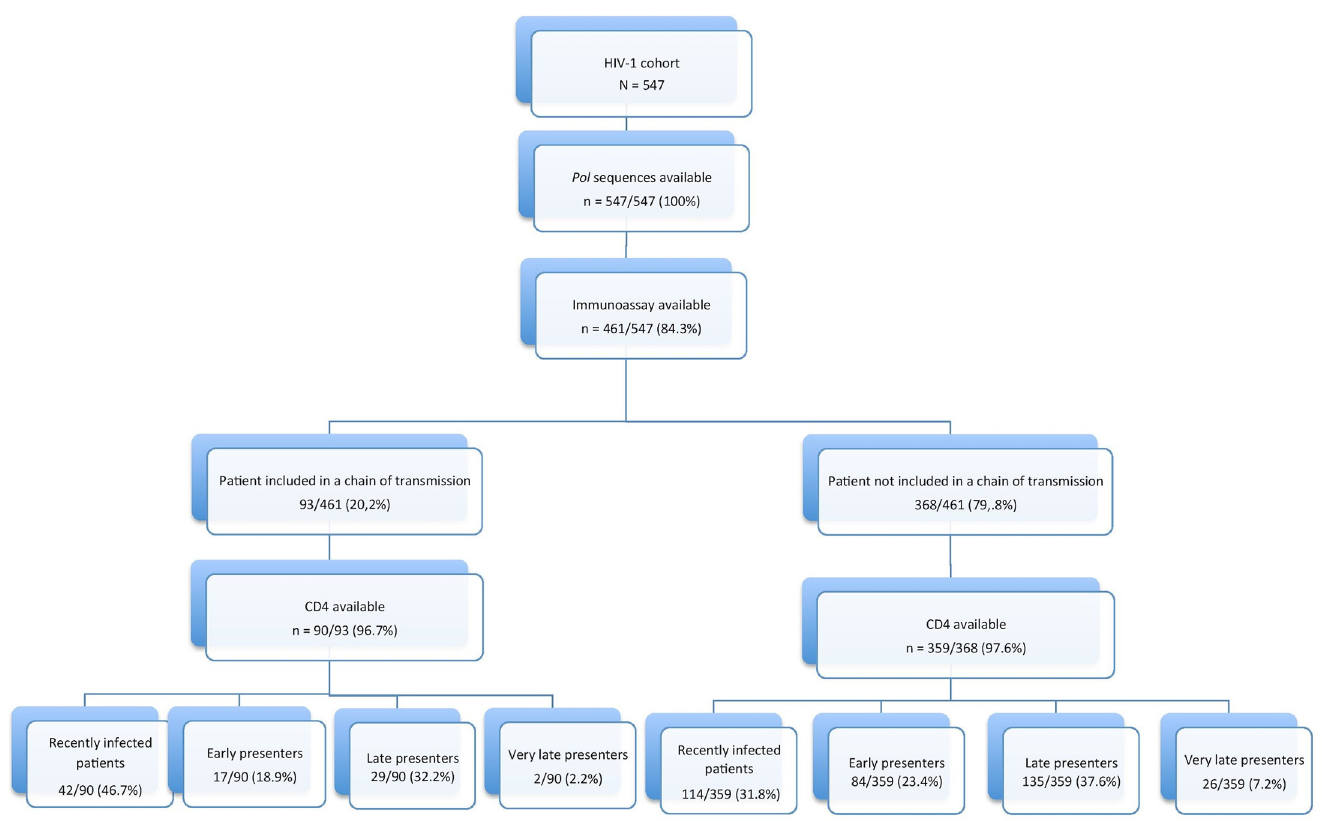
Fig 2. Distribution of the study population between chained and non-chained groups by time lapse between infection and genotyping. VEP: Very early presenter, EP: early presenter; LP: late presenter; and ELP: extremely late presenter.